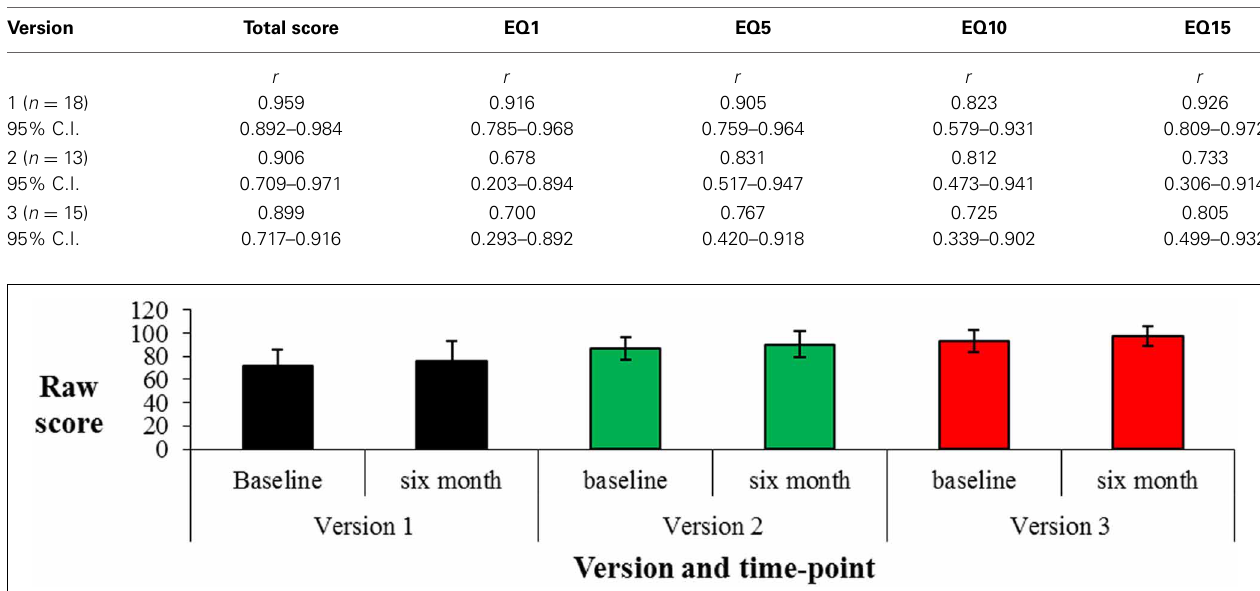
FIGURE 1 | Scores on each version [mean ( sd )] at baseline and 6 month follow-up on each version of the Public Events Questionnaire.